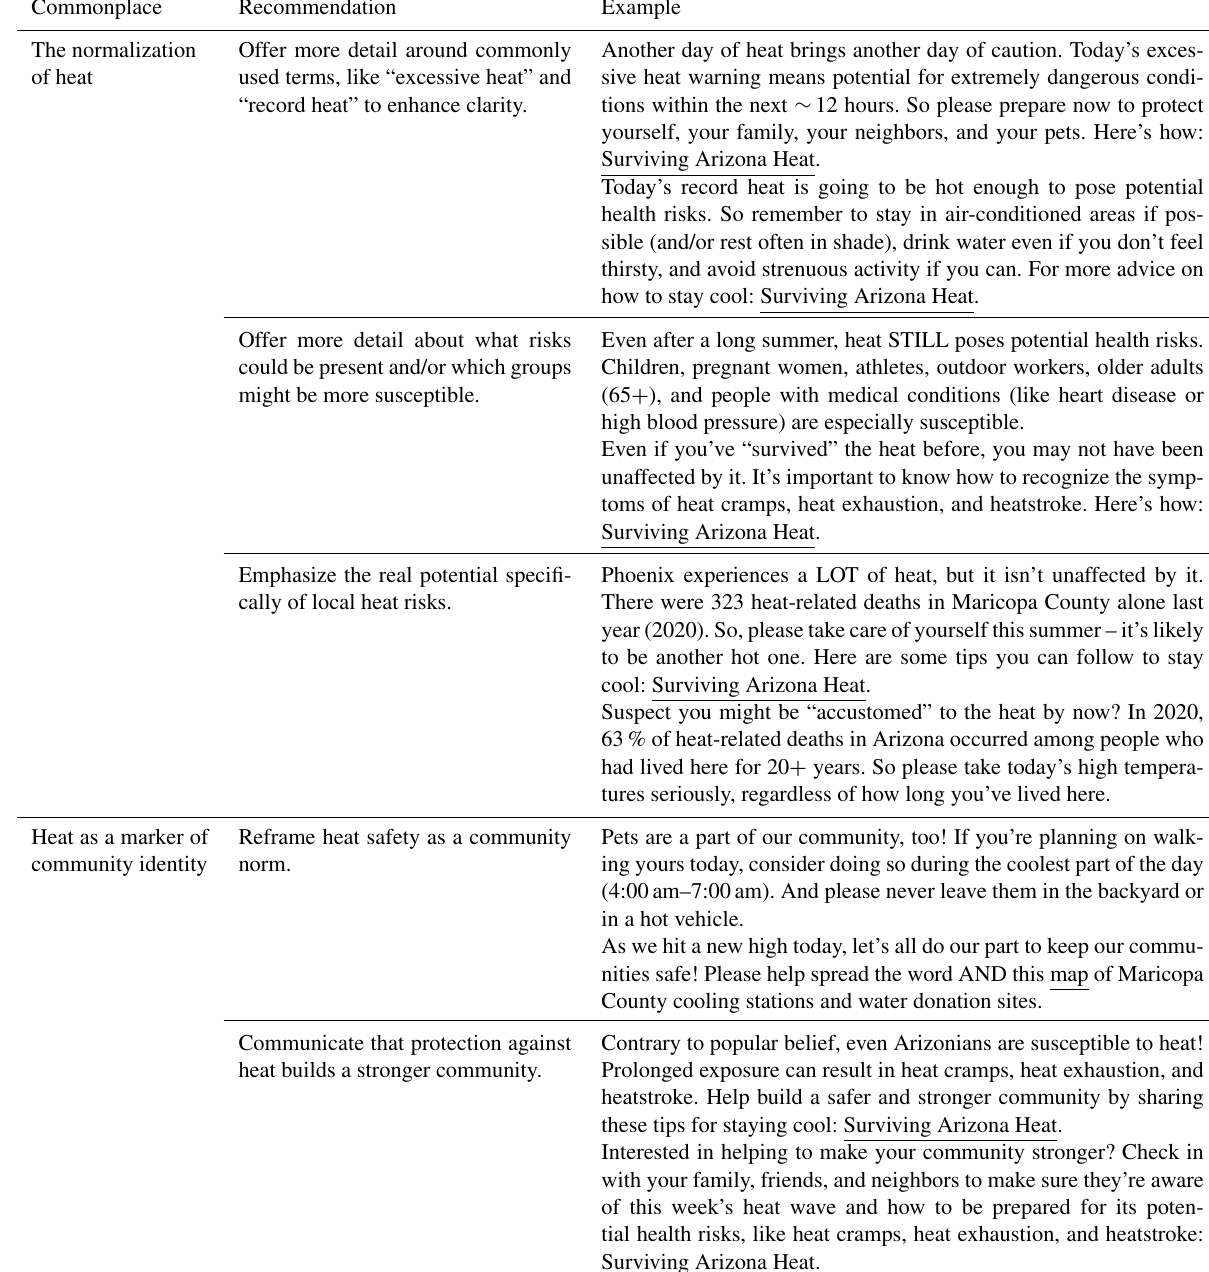
Table A1. Suggested examples of heat risk messaging informed by the commonplaces identified. Commonplace Recommendation Example The normalization of